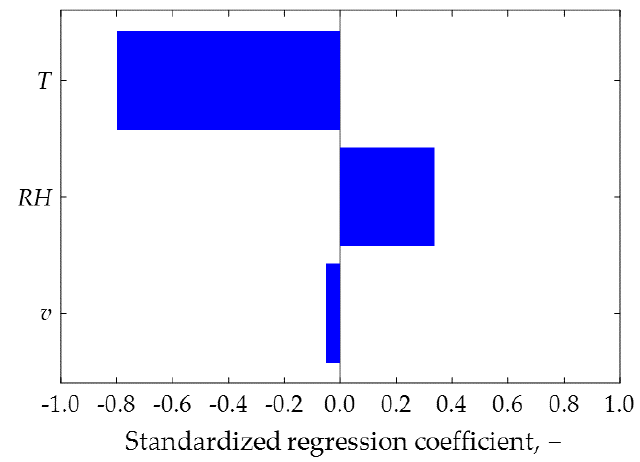
Figure 7. Standardized regression coefficient from sensitivity analysis comprising temperature T , relative humidity RH and airflow velocity v .